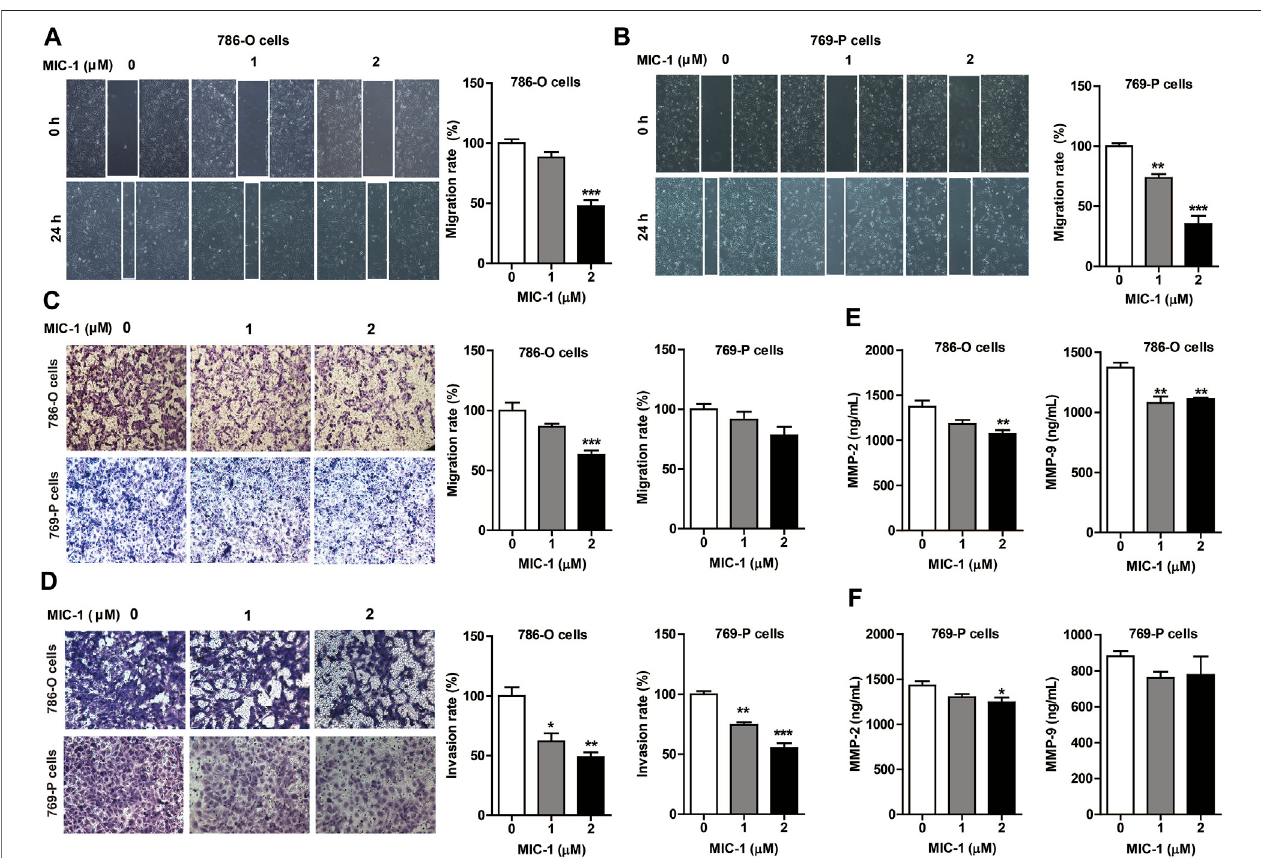
FIGURE 2 | MIC-1 inhibits the migratory and invasive capability of RCC cells. 786-O cells and 769-P cells were treated with MIC-1 (0, 1, or 2 μ M) for 24 h. The migratory ability of 786-O cells and 769-P cells were analyzed using a wound healing assay (A,B) and a Transwell assay (C) , while their invasive ability were analyzed using a Transwell assay with Matrigel-coated inserts (D) . Migrated or invaded cells were counted in fi ve randomly selected fi elds. The number ofcells in each imagewas counted using the ImageJ software. The data are presented as percentage of cell migration or invasion relative to control. (E,F) The expression of MMP-2 and MMP-9 insupernatant of786-Ocellsand 769-Pcellswasdetected bydouble-antibodyone-stepsandwichenzyme-linkedimmunosorbent assay.Values represent the means ± SEMfromthreeindependentexperimentsandstatisticalanalysiswasperformedbyone-wayANOVA;* p < 0.05,** p < 0.01,*** p < 0.001:MIC-1comparedwith the control (0 μ